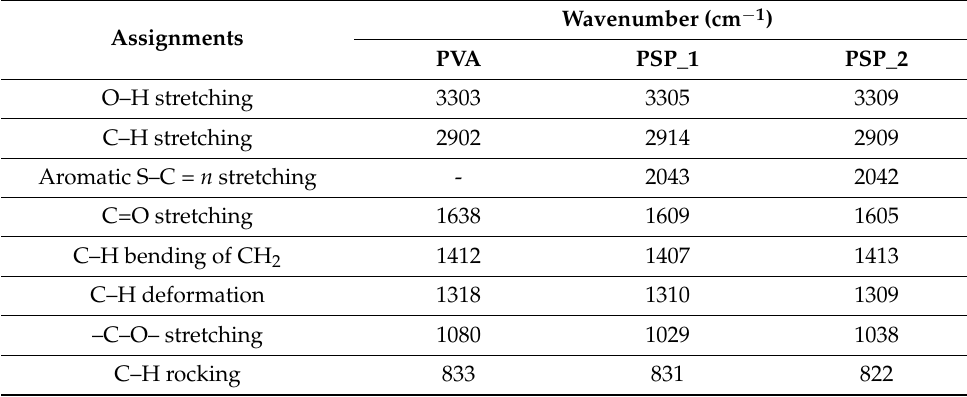
Figure 2. FTIR spectra for ( i ) pure poly (vinyl alcohol) (PVA), ( ii ) PSP_1, and ( iii ) PSP_2 from ( a ) 450 to 1900 cm − 1 and ( b ) 1900 to 4000 cm − 1 . Table 1. The FTIR results of PVA and plasticized systems.